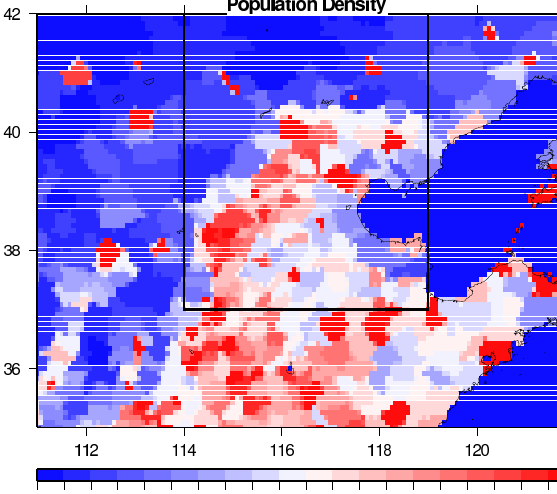
Fig. 8. Monthly mean 0–6km ozone columns from IASI spatially averaged on a 0.25 ◦ × 0.25 ◦ latitude-longitude grid for 2008 in the Beijing region (given in Dobson Unit,DU). Beijing location is in- dicated by a brown star. Black squares when no data is available in the grid cell.